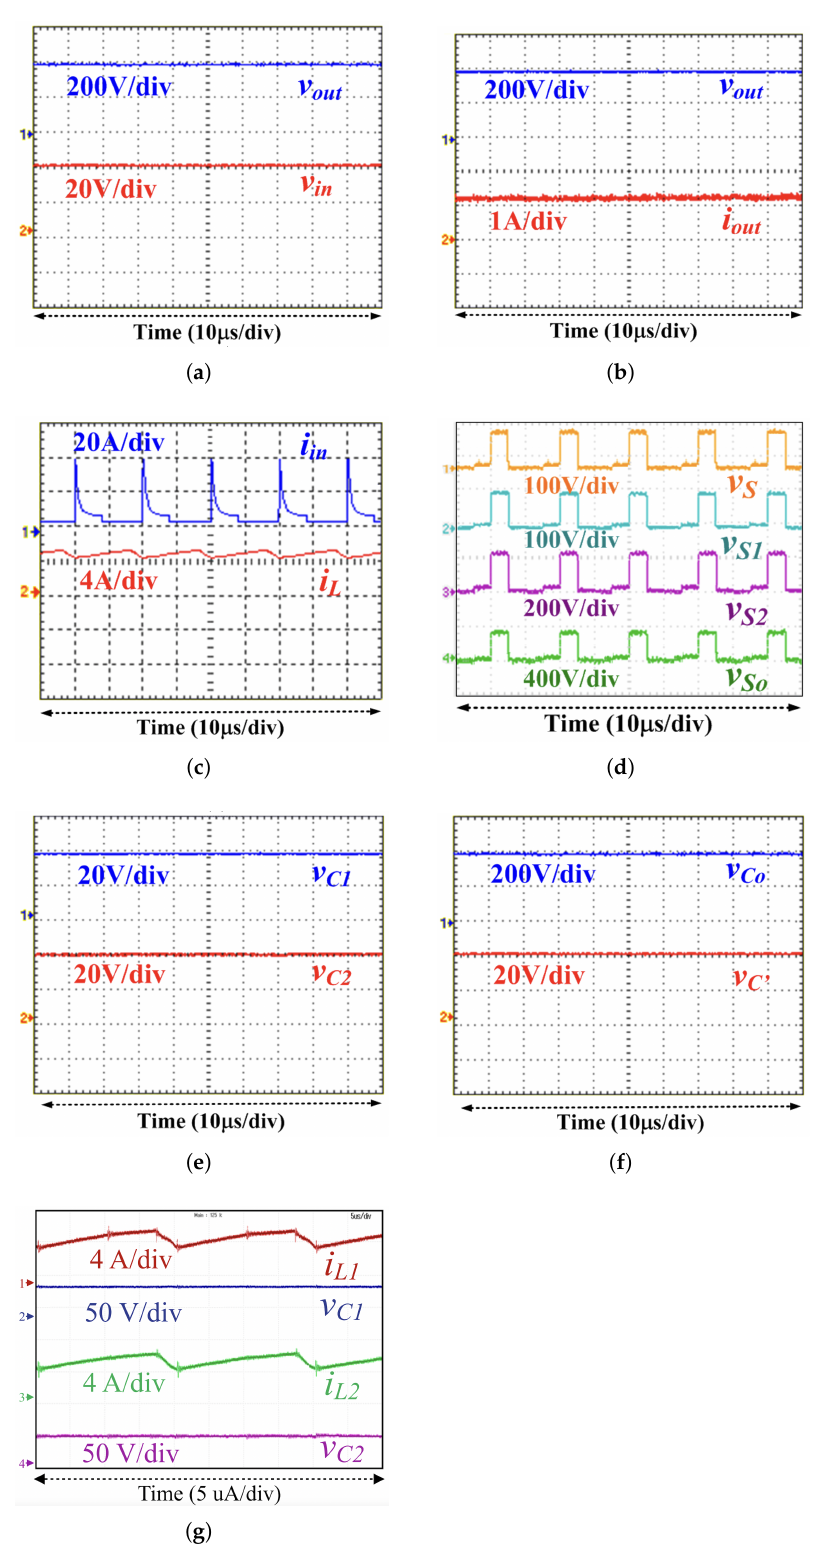
Figure 16. Results, ( a ) v out and v in , ( b ) v out and i out , ( c ) i in and i L , ( d ) v S , v S 1 , v S 2 , and v So , ( e ) v C 1 and v C 2 , ( f ) v C (cid:48) and v Co , ( g ) i L 1 , i L 2 , v C 1 and v C 2